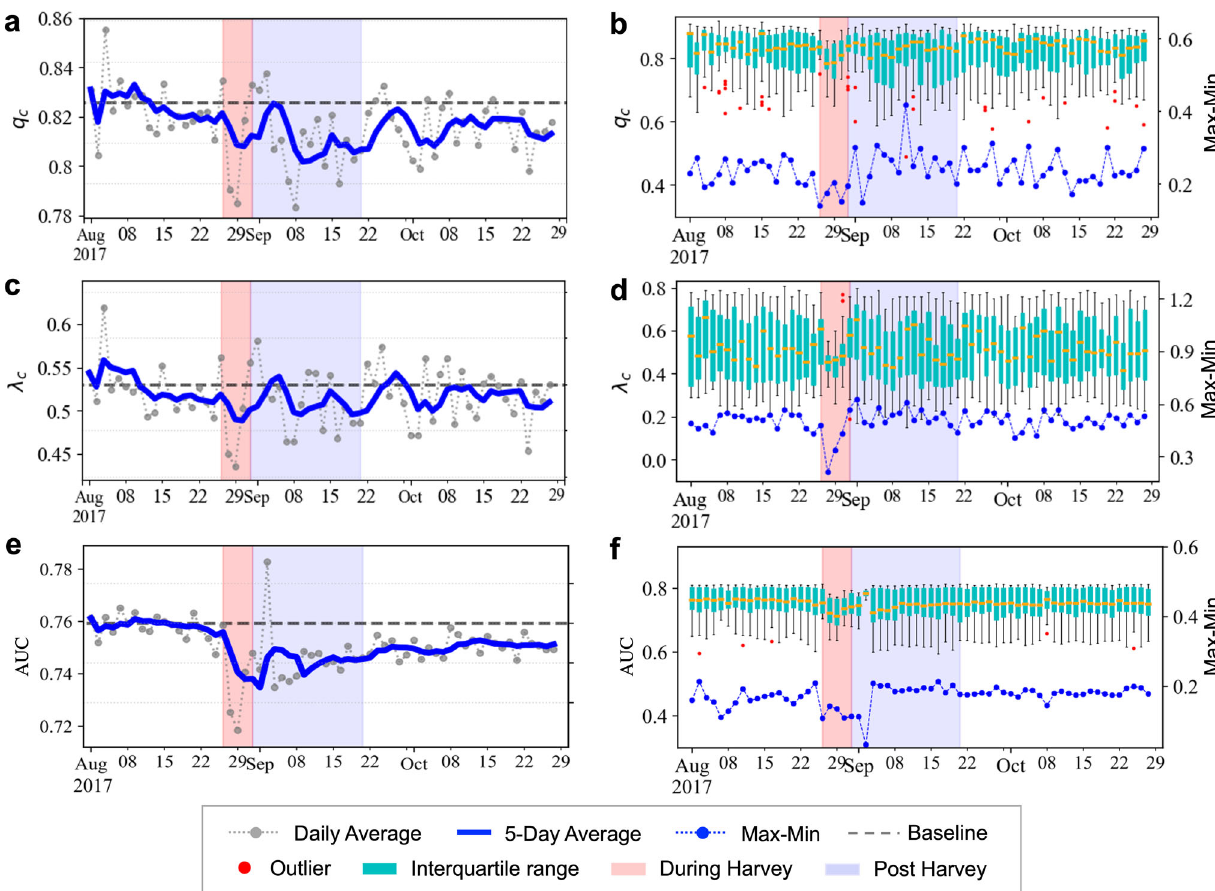
Fig. 4 Temporal variation of percolation critical thresholds q c and λ c and area under the curve (AUC) on weekdays. a , c , e Time series of average q c , λ c , and AUC (blue solid lines). The baseline is calculated based on the two-week average values for the period prior to Hurricane Harvey. b , d , f Temporal variation range of q c , λ c , and AUC (turquoise bar). Max – min curve (blue dot solid line) is generated by subtracting their maximum and minimum value each